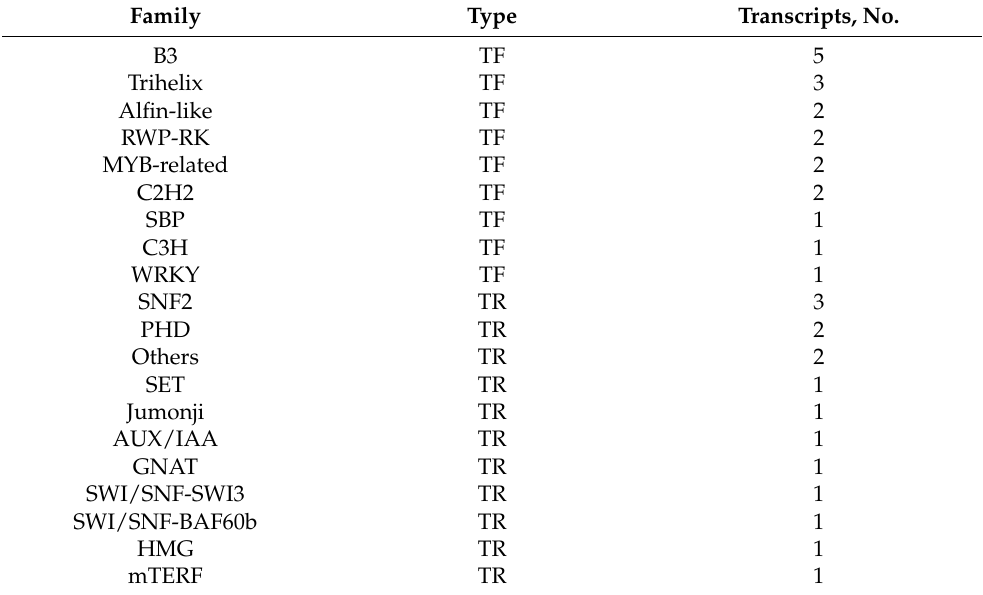
Table 2. List of transcription factors (TF) and transcriptional regulators (TR) identified among the pre-miRNA targets. The number of transcripts/family is also reported. Family Type Transcripts, No.